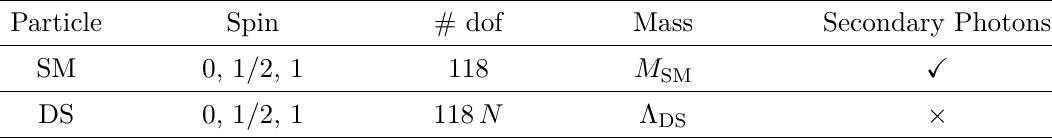
Table 4 . Particle content of the Dark Sector